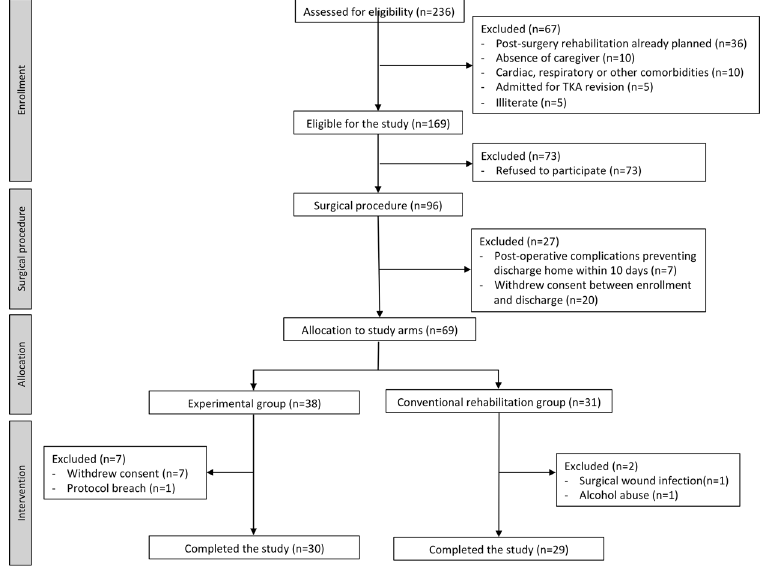
Figure 1. Study CONSORT